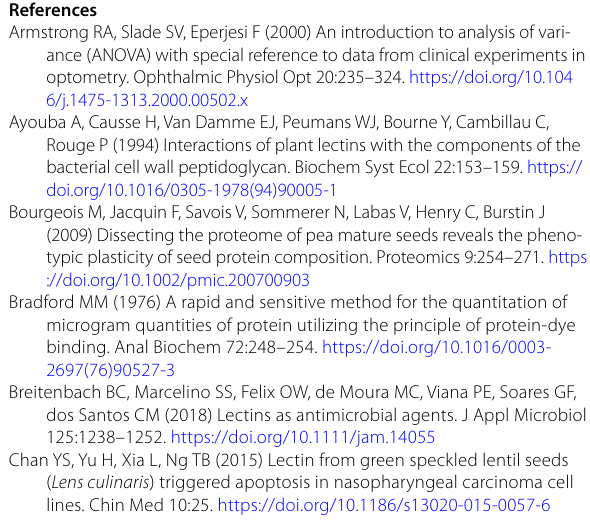
0.98 Da) of asparagines (N) and glutamines +